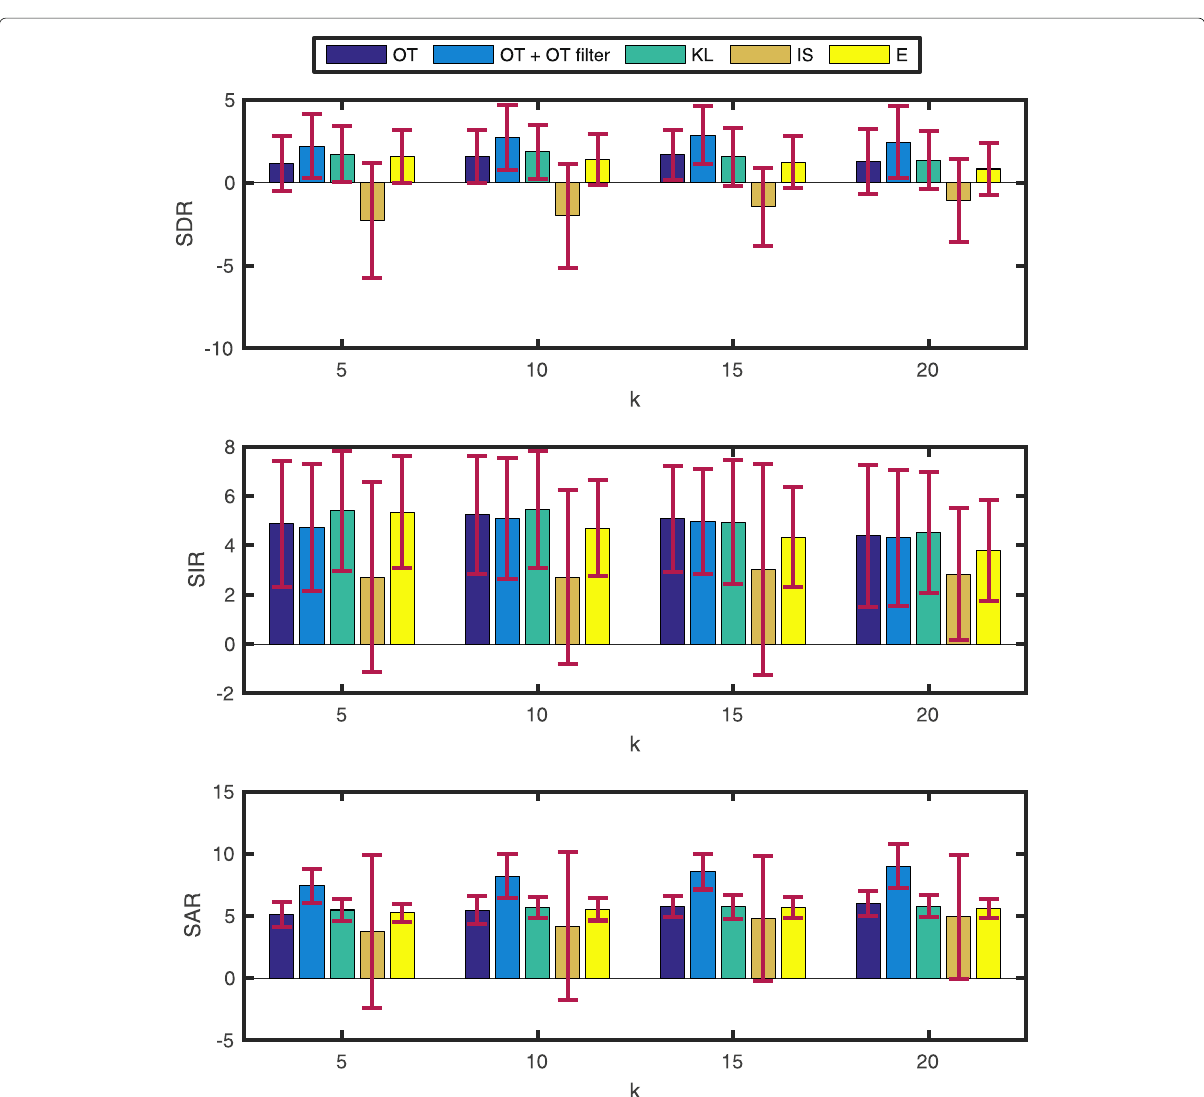
Fig. 7 Voice-voice separation score (cross-domain). Average and standard deviation of SDR, SIR, and SAR scores for voice BSS, in the cross-domain setting where training spectrograms have fewer frequencies than testing spectrograms. The scores are for NMF with optimal transport (dark blue), optimal transport with our generalized filter (light blue), Kullback-Leibler (green), Itakura-Saito (brown), or Euclidean (yellow)